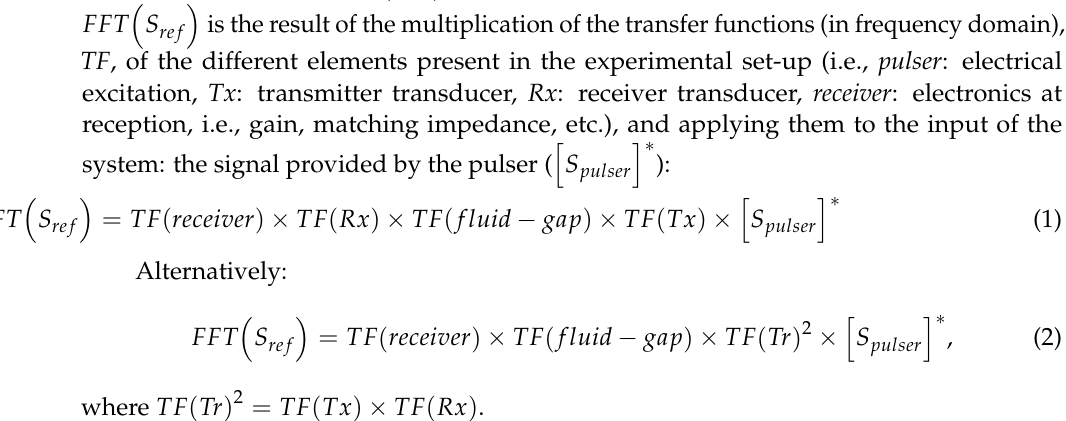
Figure 4. Water tank for water immersion measurements.